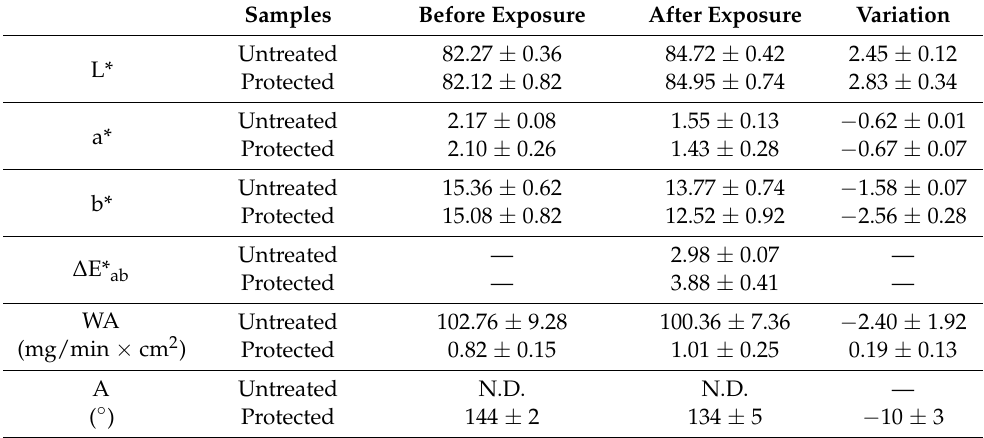
Table 5. Color parameters (L*, a*, b*), color change ( ∆ E* ab ), water absorption by “contact sponge” test (WA), and water-stone static contact angle ( α ) in the samples before and after the application of the protective treatments. Samples Before Exposure After